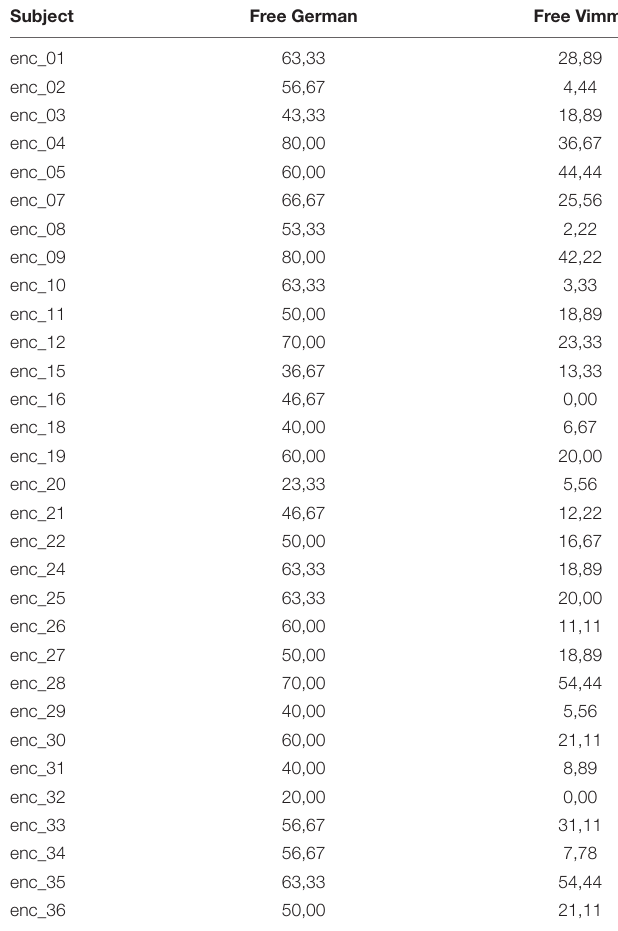
TABLE 3 | Behavioral average performances in free Vimmi and free